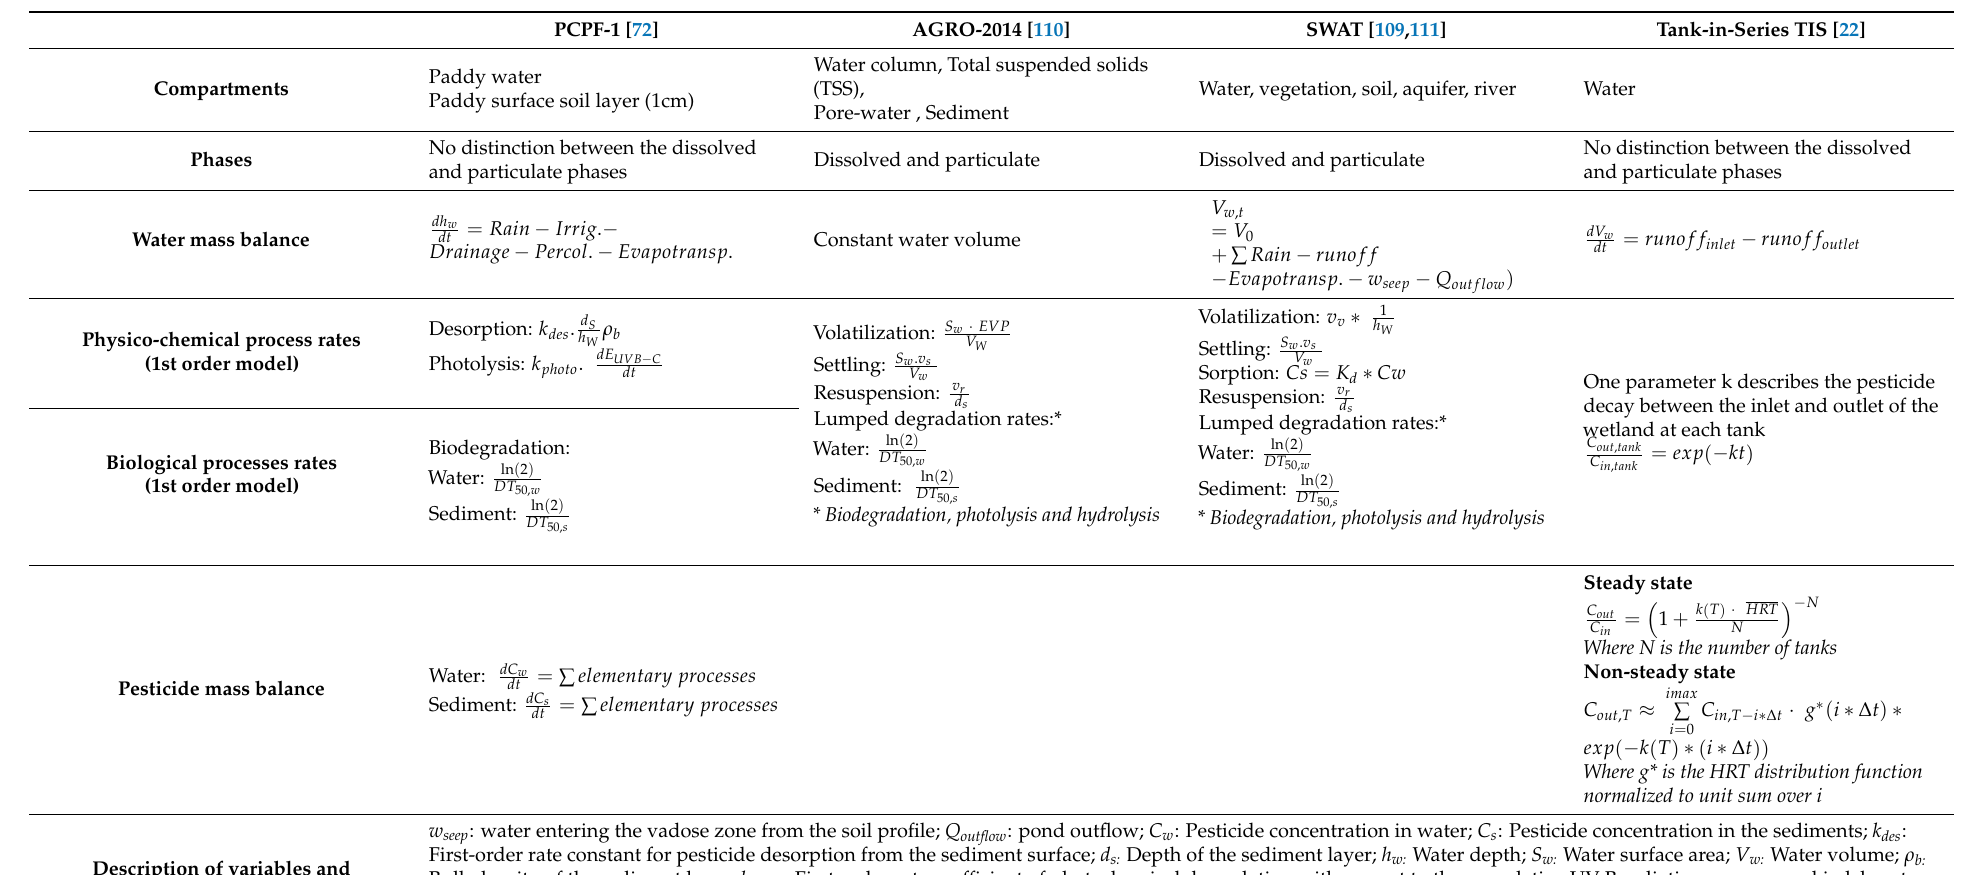
Table 2. Lumped models for pesticide dissipation in wetlands, lakes or paddy fields. The lumped models could be adapted to predict pesticide dissipation in ponds. PCPF-1 [72] AGRO-2014 [110] SWAT [109,111] Tank-in-Series TIS [22] Water column, Total suspended solids Paddy water Compartments (TSS), Water, vegetation, soil, aquifer, river Water Paddy surface soil layer (1cm) Pore-water , Sediment No distinction between the dissolved No distinction between the dissolved Phases Dissolved and particulate Dissolved and particulate and particulate phases and particulate phases Water mass